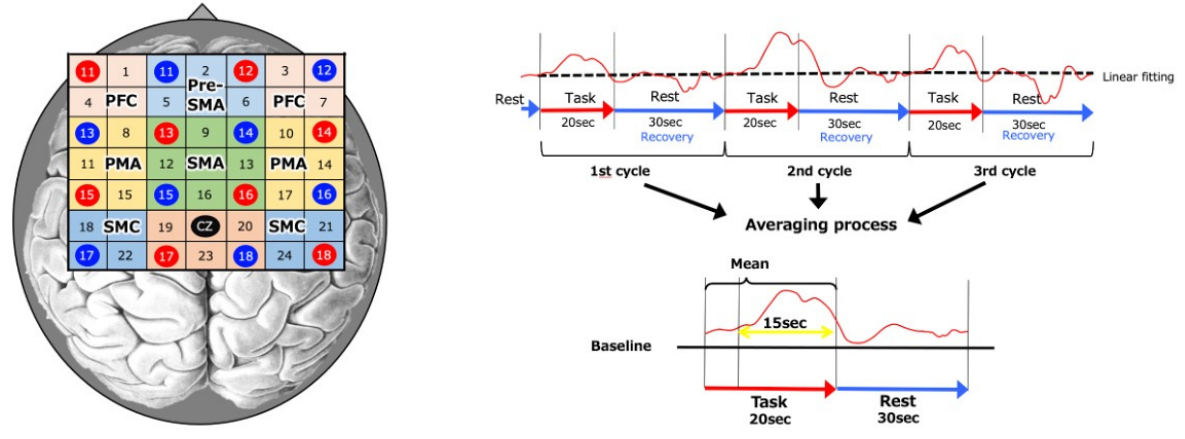
Figure 4. Near-infrared spectroscopy (NIRS). NIRS measurements were performed using an optical topography system. NIRS probes were positioned at the Cz position (midpoint of the crown of the head) according to the international 10–20 method in a 4 × 4 probe set. As for the baseline, the data were averaged over the 5 s immediately prior to the start of the MI task and the 5 s following its completion. The data recorded 5 s following the start of the MI task until 20 s following its completion (15 s of data) were used.